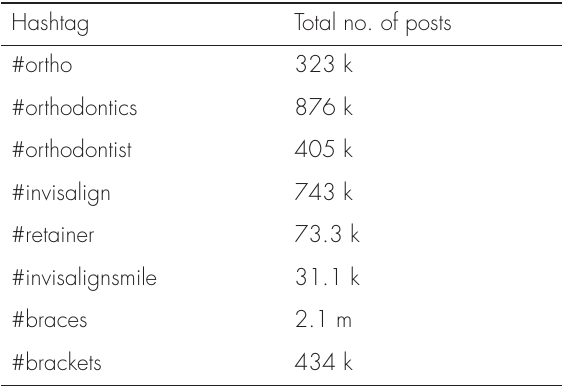
Table I. Orthodontics-related hashtag utilisation on